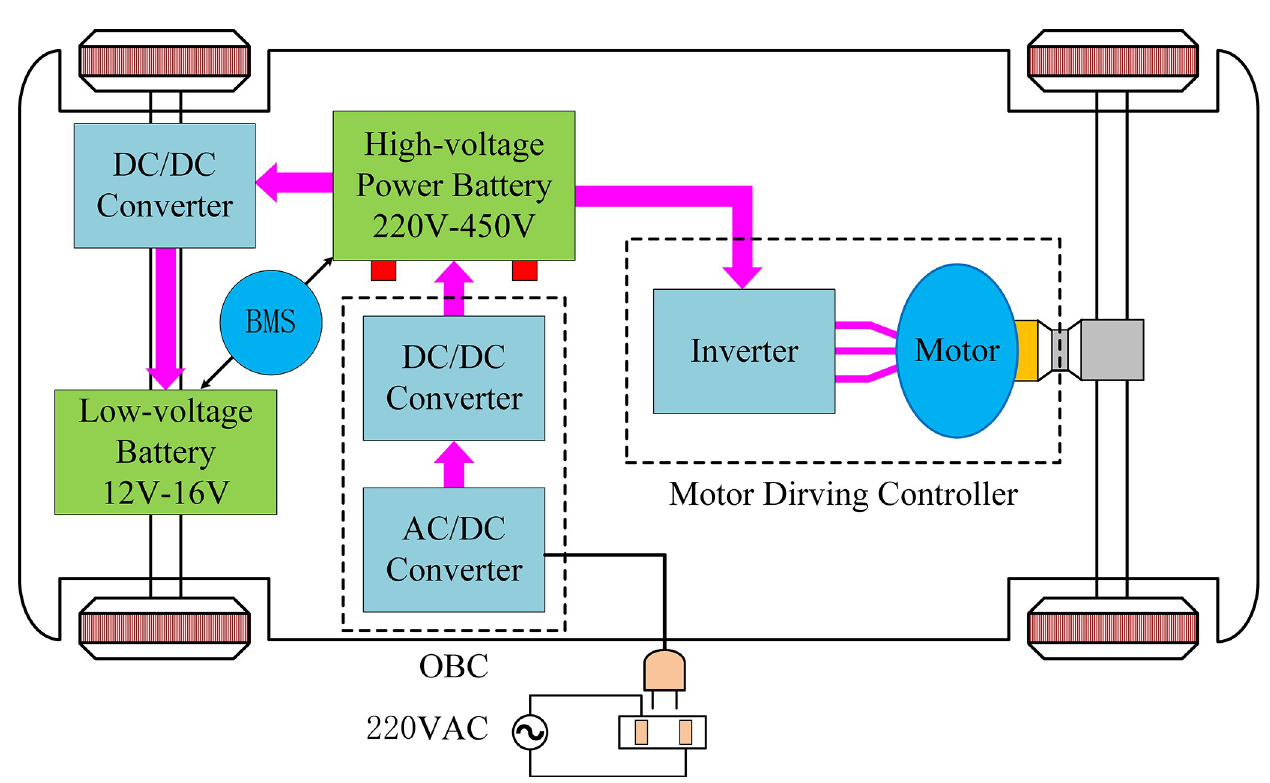
Fig 1. Typical electric structure of PEV.